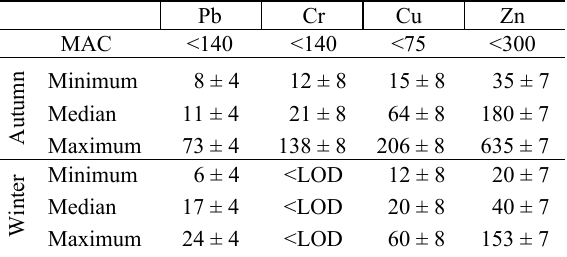
Table 2. The comparison of minimum, median and maximum winter and autumn Pb, Cr, Cu and Zn values (in mg/kg) with maximum allowable concentrations (MAC) in bottom sedi- ments of surface water bodies (LME 2014). LOD – level